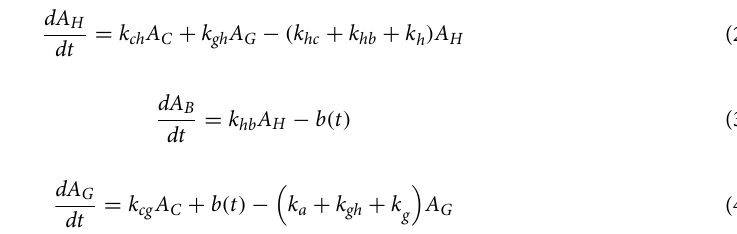
where A C , A H , A B and A G stands for drug amount in the central, hepatocyte, gallbladder, and intestinal compart- ments, respectively. First-order rate constants for mass transferences are k a (drug absorption from the gut into the central compartment), k hc (drug transference from the hepatocyte to the central compartment), k ch (drug transference from the central compartment to the hepatocyte), k cg (drug transference from the systemic circula- tion to the gut), k gh (hepatic uptake of drug coming from the gut through portal venous blood), k hb (hepatobiliary secretion), k r (renal elimination), k h (hepatic elimination) and k g (intestinal elimination). Of note, k a reflects intestinal drug absorption bypassing the hepatocytes throughout liver capillaries and extracellular space. Enterogastric reabsorption (EGR). To represent EGR (Fig. 2b), the same principles described above were implemented. The stomach was separated from the gastrointestinal space and displayed in two separated com-